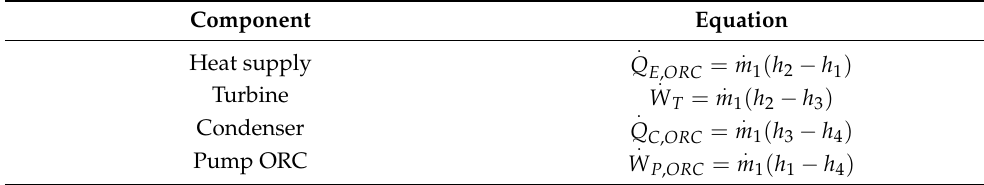
Table 1. Energy balances for the organic Rankine cycle.